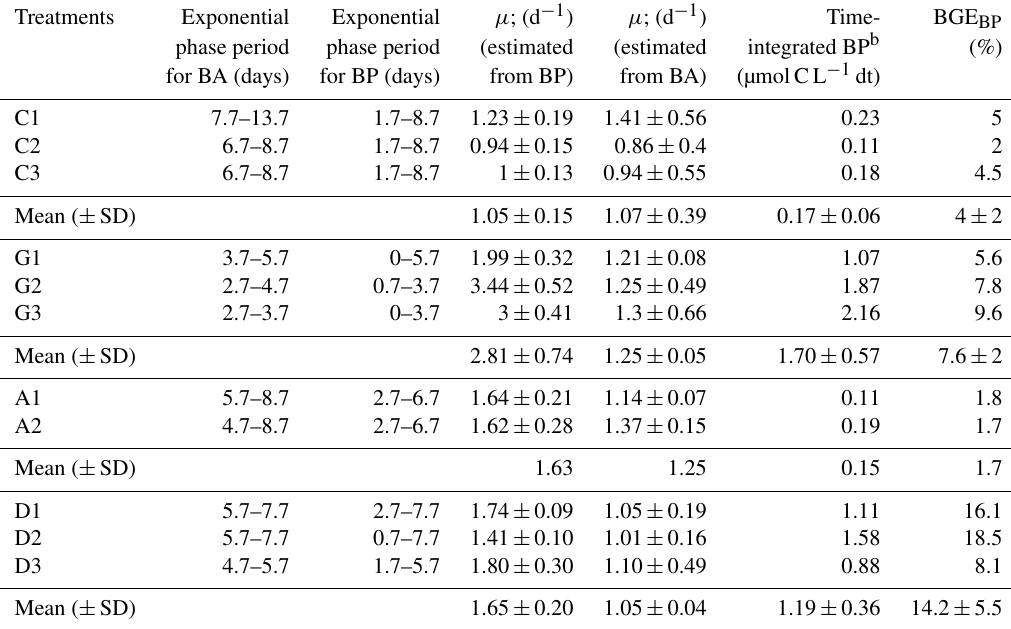
Figure 3. Changes in heterotrophic bacterial abundance (BA; a ) and production (BP, b ) over the incubation period in glucose (left, green plots), anthropogenic aerosols (middle, gray plots), and Saharan dust aerosols (right, orange plots). The control is plotted in each panel: the average value is represented by the stars and the standard deviation by the bounded lines. Table 3. Duration of the exponential growth phase for bacterial abundance (BA) and bacterial production (BP), bacterial growth rate ( µ ) estimated from both BP and BA changes during the exponential growth phase, time-integrated BP during the exponential growth phase, and bacterial growth efficiency (BGE). Data from each triplicate and average ( ± SD) values are given for the control (C), glucose, anthropogenic, and Saharan dust